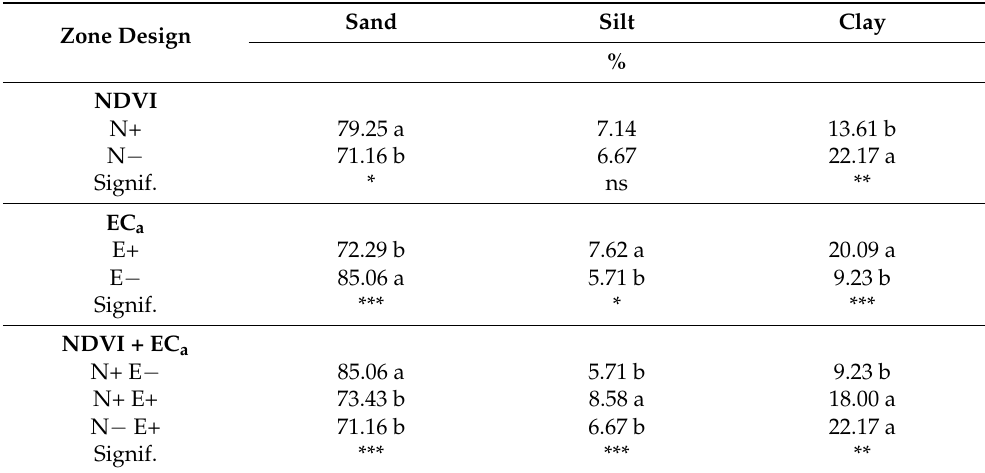
Table 1. Mean values of soil percentage of sand, silt, and clay according to zone and indicator